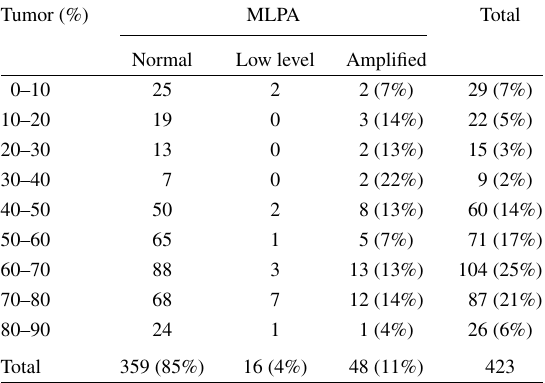
MLPA HER-2 test results for 423 cases divided into groups accord- ing to tumor percentage Tumor